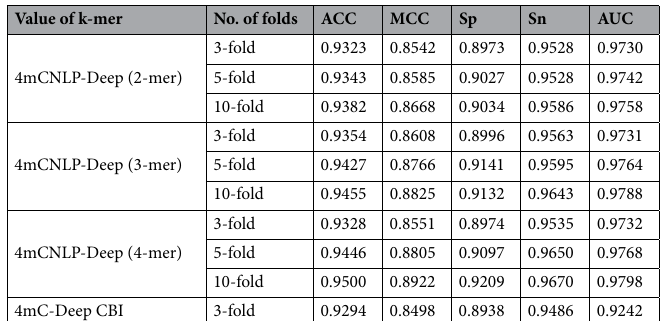
Table 3. Results demonstration of 4mCNLP-Deep with different experimental values compare to state-of-the- art model on benchmark dataset for C. elegans .